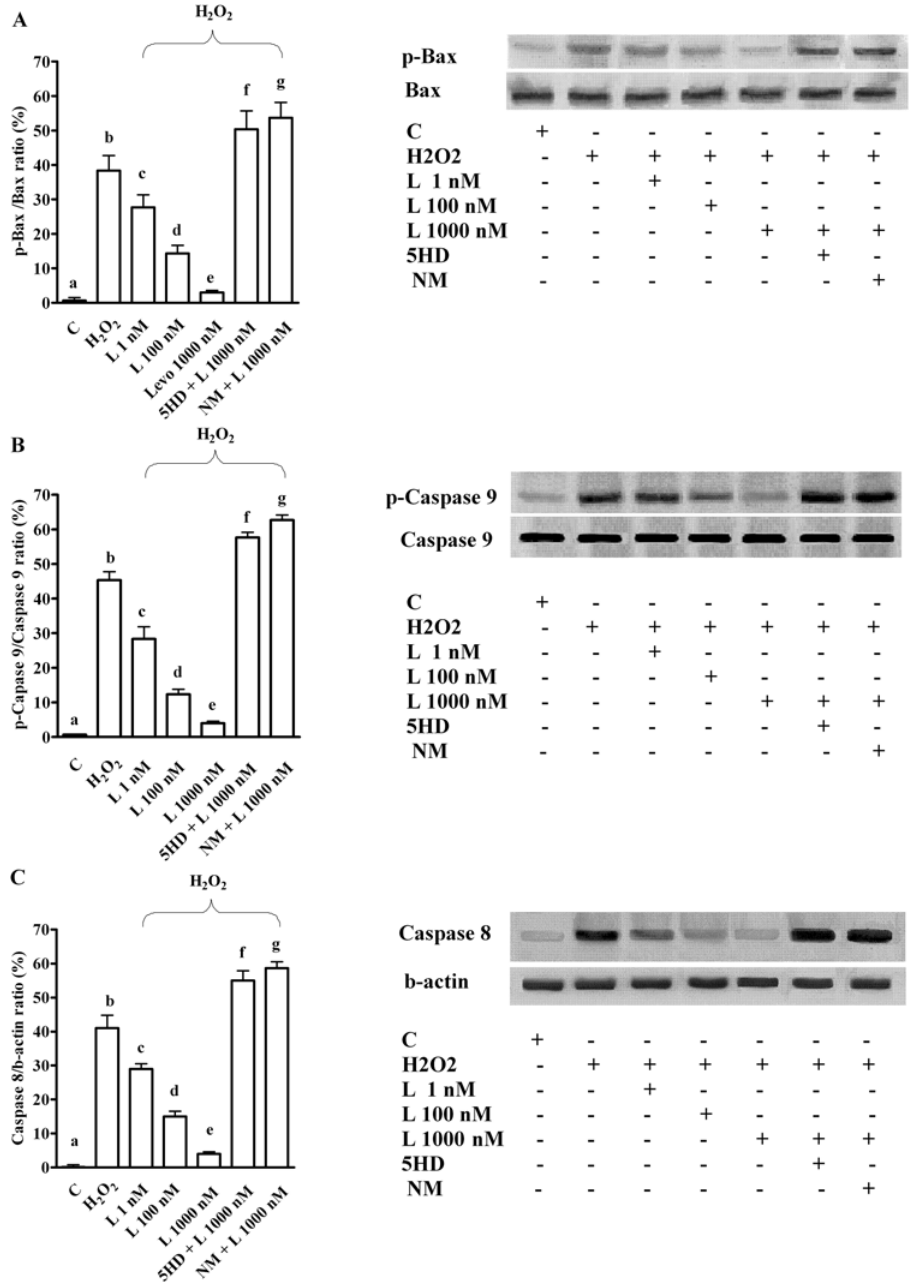
Fig 6. Effects of levosimendan on apoptosis caused by peroxidation in hepatocytes. In A, B and C, effects of levosimendan on p-Bax, p-Caspase 9 and Caspase 8, respectively. Densitometric analysis and an example of lanes taken in one of 5 different experiments performed for each experimental protocol are reported. Abbreviations are as in Figs 1 – 5. b, c, d, e, f, g P < 0.05 vs a; c, d, e, f, g P < 0.05 vs b; d, e P < 0.05 vs c; d, f, g P < 0.05 vs e. The results of densitometric analysis are expressed as means of 5 independent experiments (%) ± SD (indicated by the